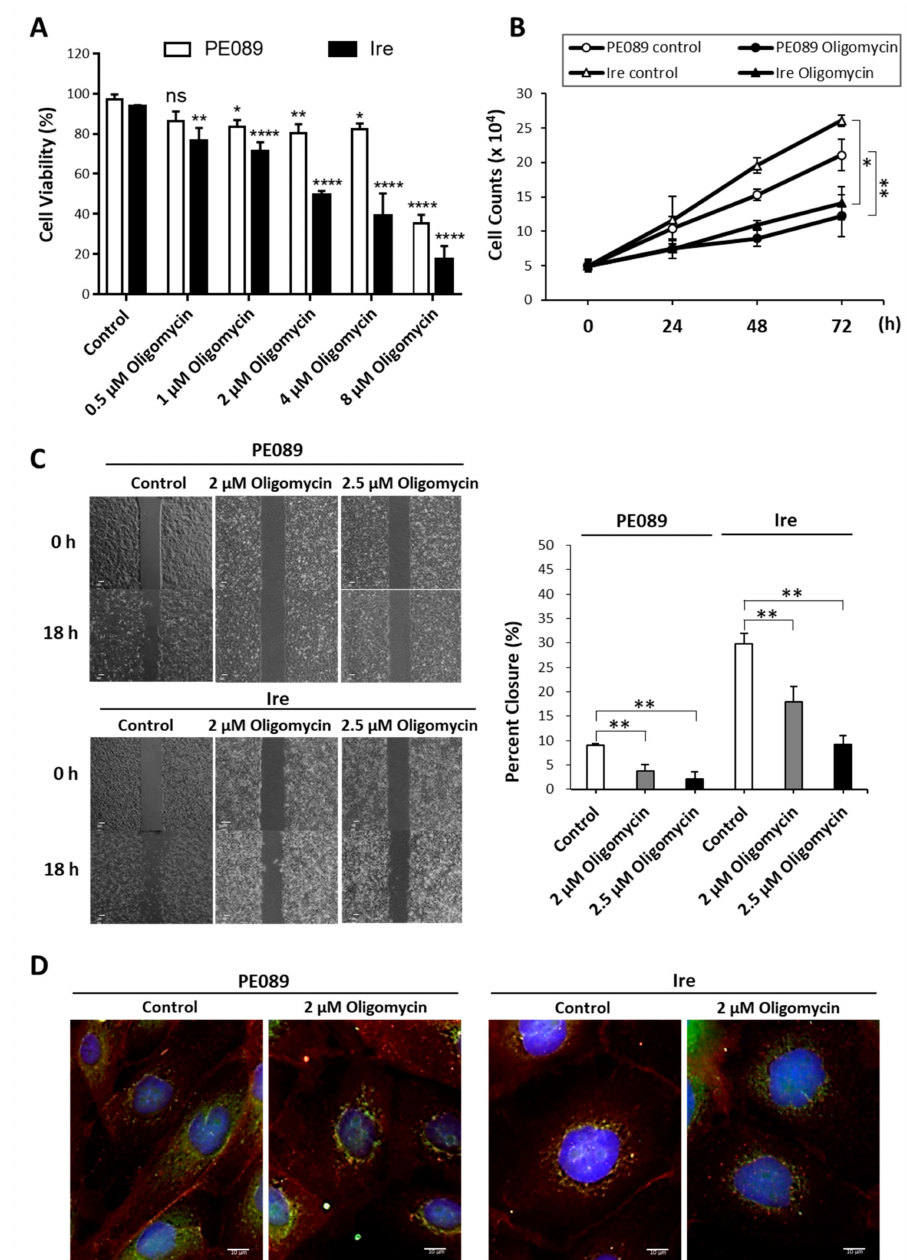
Figure 5. Mitochondrial bioenergetics contributed to the cell survival, cell proliferation, and cell motility of PE089 and Ire cells. ( A ) Dose-dependent cell viability assay. Reduction in cell viability was assessed in PE089 cells and Ire cells after di ff erent concentrations of oligomycin in 2% FBS medium. The star signs showed the significant di ff erences compared to the control group for each cell. ( B ) Proliferation of PE089 and Ire cells in response to 2 µ M oligomycin for 0, 24, 48, and 72 h was measured by the trypan blue-dye exclusion method. ( C ) The cell motility of PE089 and Ire cells in response to 2 or 2.5 µ M oligomycin was determined by wound healing assay. Images were taken at 0 and 18 h, and the bar chart was calculated from the images. Significant inhibition by oligomycin of cell proliferation, cell survival, and cell motility was found in both PE089 and Ire cells. ( D ) PE089 and Ire cells were subjected to immunofluorescent staining with or without 2 µ M oligomycin for 24 h. The cells were immunodetected by anti-EGFR-CF594 (red signals) and anti-HSP60-CF488A (green signals). Cell nuclei were stained with DAPI (blue signals) (scale bars, 10 µ m). The control is no oligomycin treatment. The values represent the mean ± S.D. from three independent experiments and each experiment performed in duplicate. * p < 0.05. ** p < 0.01. **** p <